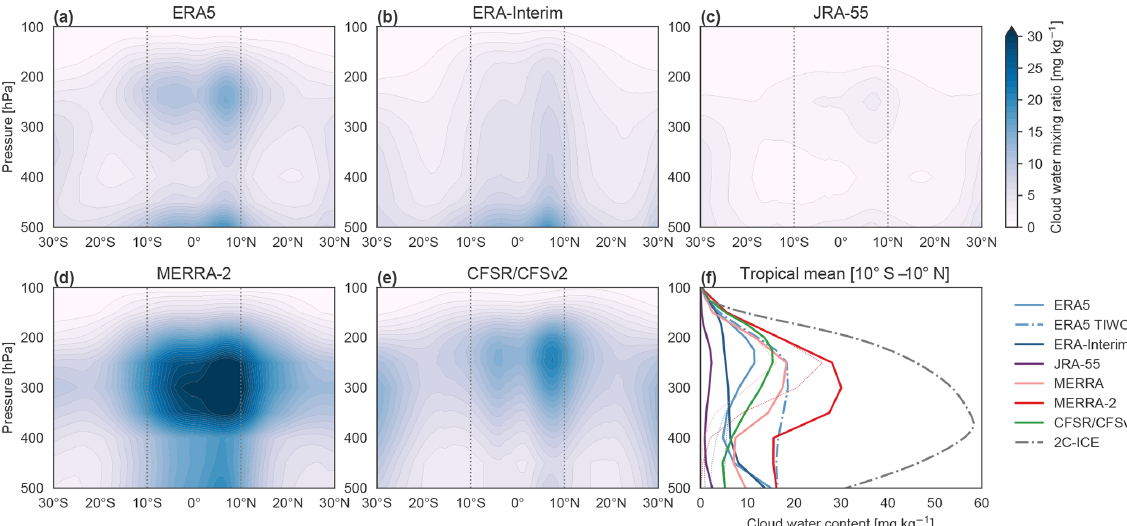
Figure 4. Time-mean zonal-mean distributions of total cloud water content based on the (a) ERA5, (b) ERA-Interim, (c) JRA-55, (d) MERRA-2, and (e) CFSR/CFSv2 reanalyses (1980–2014). Inner-tropical-mean (10 ◦ S–10 ◦ N) profiles based on these five reanalyses are shown in (f) , along with profiles from MERRA and an observationally based estimate of total ice water content (cloud ice + snow) dur- ing 2007–2010 from the CloudSat–CALIPSO 2C-ICE product. Vertical lines in (a) through (e) mark the bounds of the averaging domain. Dashed lines in (f) indicate ice-only water contents from the reanalyses that provide this information (all but CFSR/CFSv2). The total ice (TIWC; cloud ice + snow) profile from ERA5 is also included for comparison with 2C-ICE.